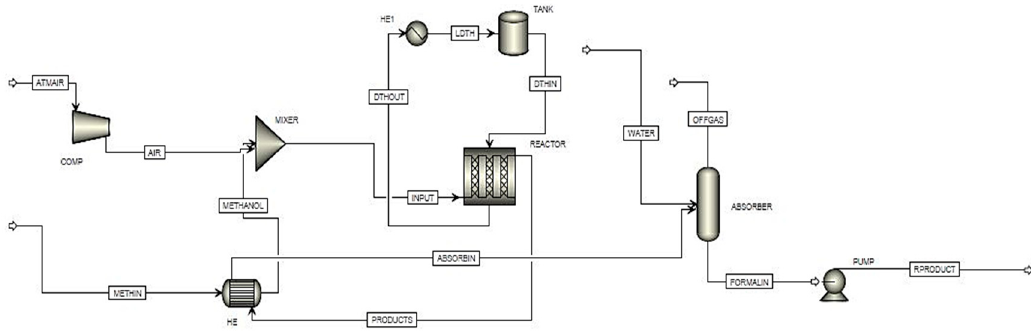
Figure 1. Simulation model of Molybdenum-based formaldehyde process.